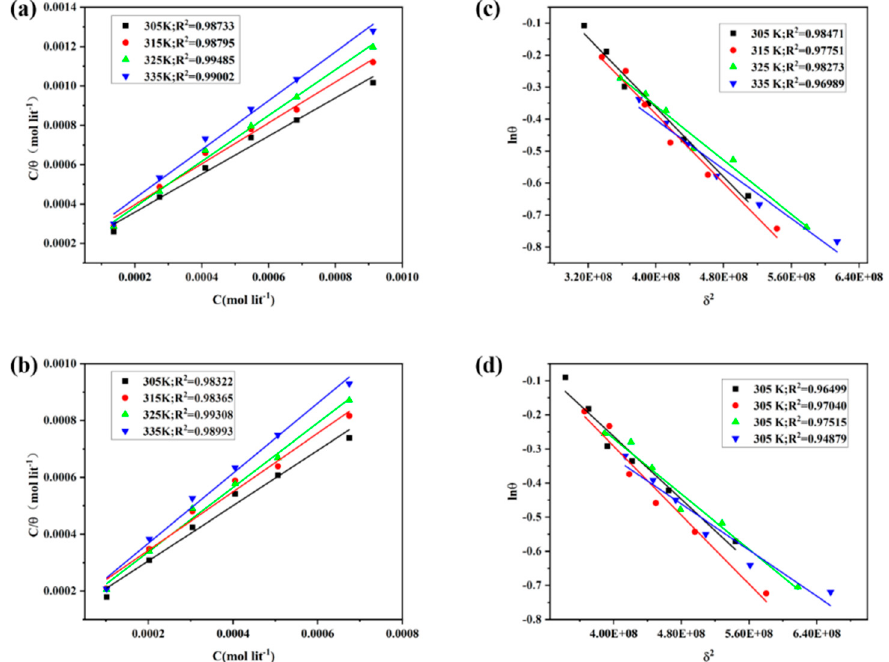
Figure 7. Langmuir isotherm ( a ) MPO, ( b ) MPPO and Dubinin–Radushkevich isotherm ( c ) MPO, ( d ) MPPO plots for N80 steel in 1 M HCl solution containing different concentrations of MPO and MPPO at different temperature.